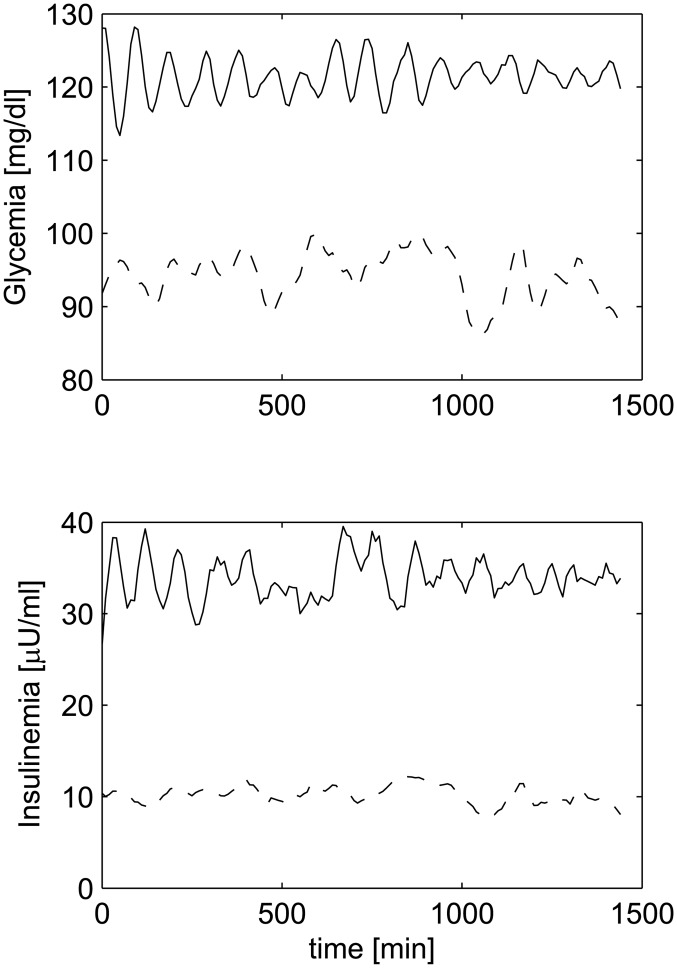
Glucose/insulin evolutions with and without enteral nutrition.Glucose (upper panel) and insulin (lower panel) evolution during a 24h period with (continuous line) and without (dashed line) enteral nutrition. Compare this figure with Fig 1 by Simon et al. [13].